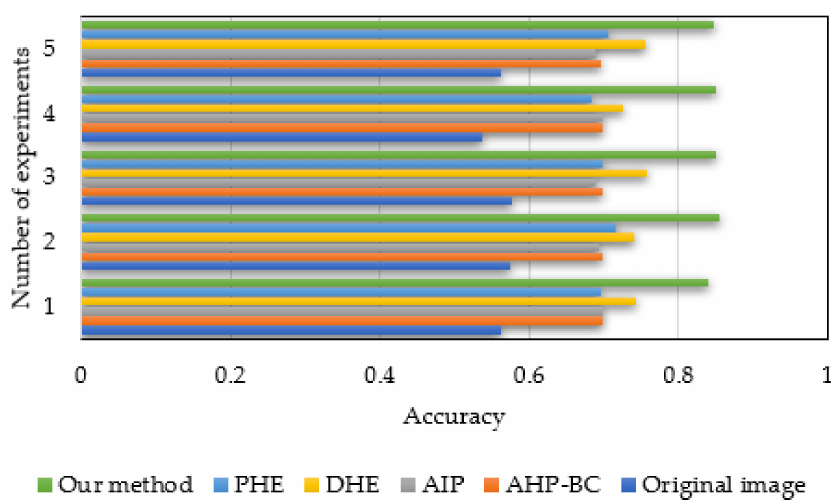
Figure 13. Accuracy of different brightness correction methods on the test set.